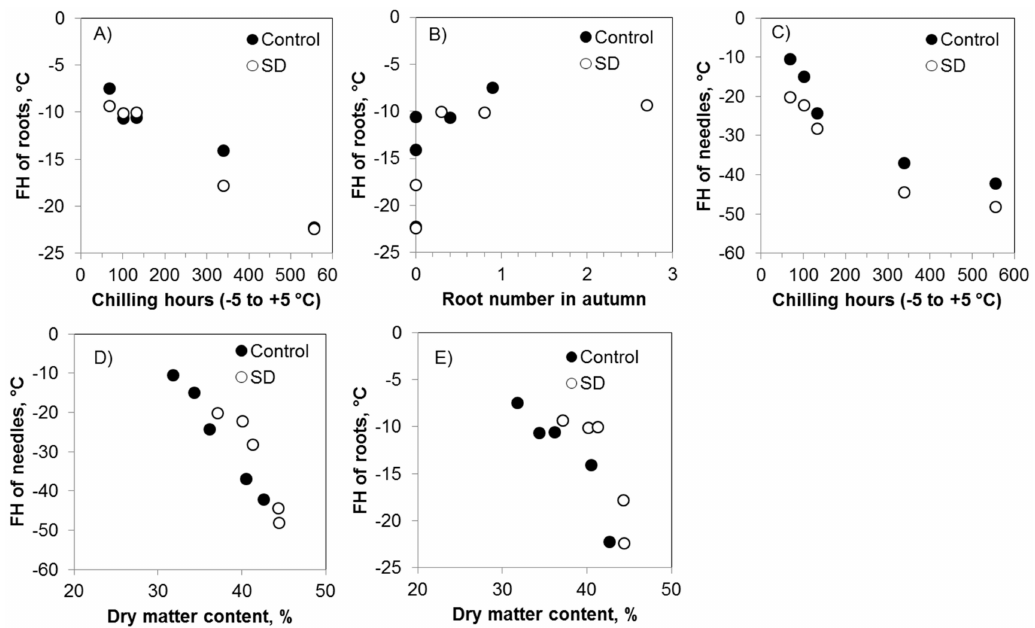
Figure 8. Relationship between ( A , B , E ) frost hardiness of roots or ( C , D ) needles and di ff erent variables [( A , C ) chilling hours, ( B ) root number, ( D , E ) dry matter content] that were used to predict storability of Norway spruce seedlings that either received short-day (SD) treatment or did not (control). FH: frost hardiness (DT 50 , the temperature at which the degree of damage of needles, stem or buds, or root number was reduced by 50%).